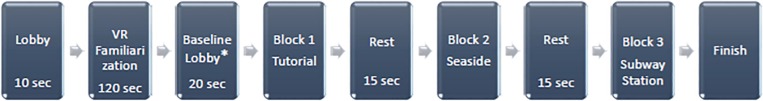
Experimental protocol work flow (∗ indicates starting point for people who had prior VR experience).